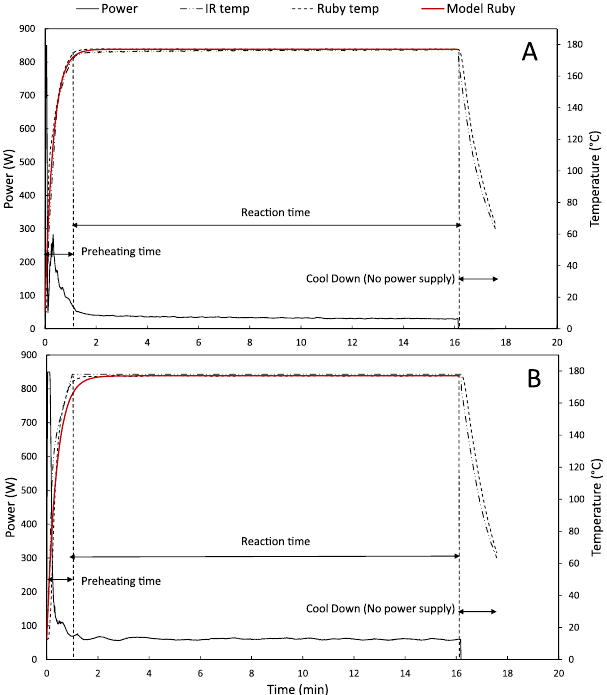
Figure 3. Heating profiles of ( A ) a borosilicate glass reaction vessel and ( B ) a SiC reaction